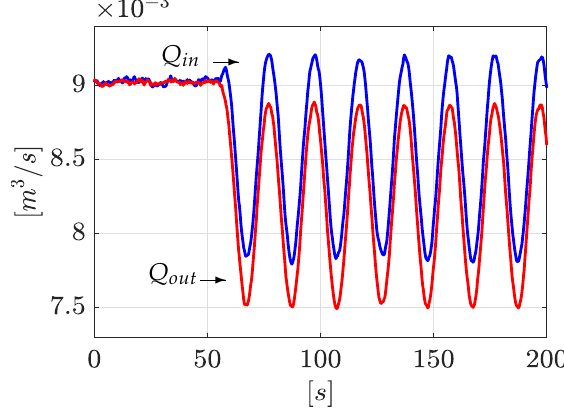
Figure 9. Flow rate Q in and Q out (2nd experiment).